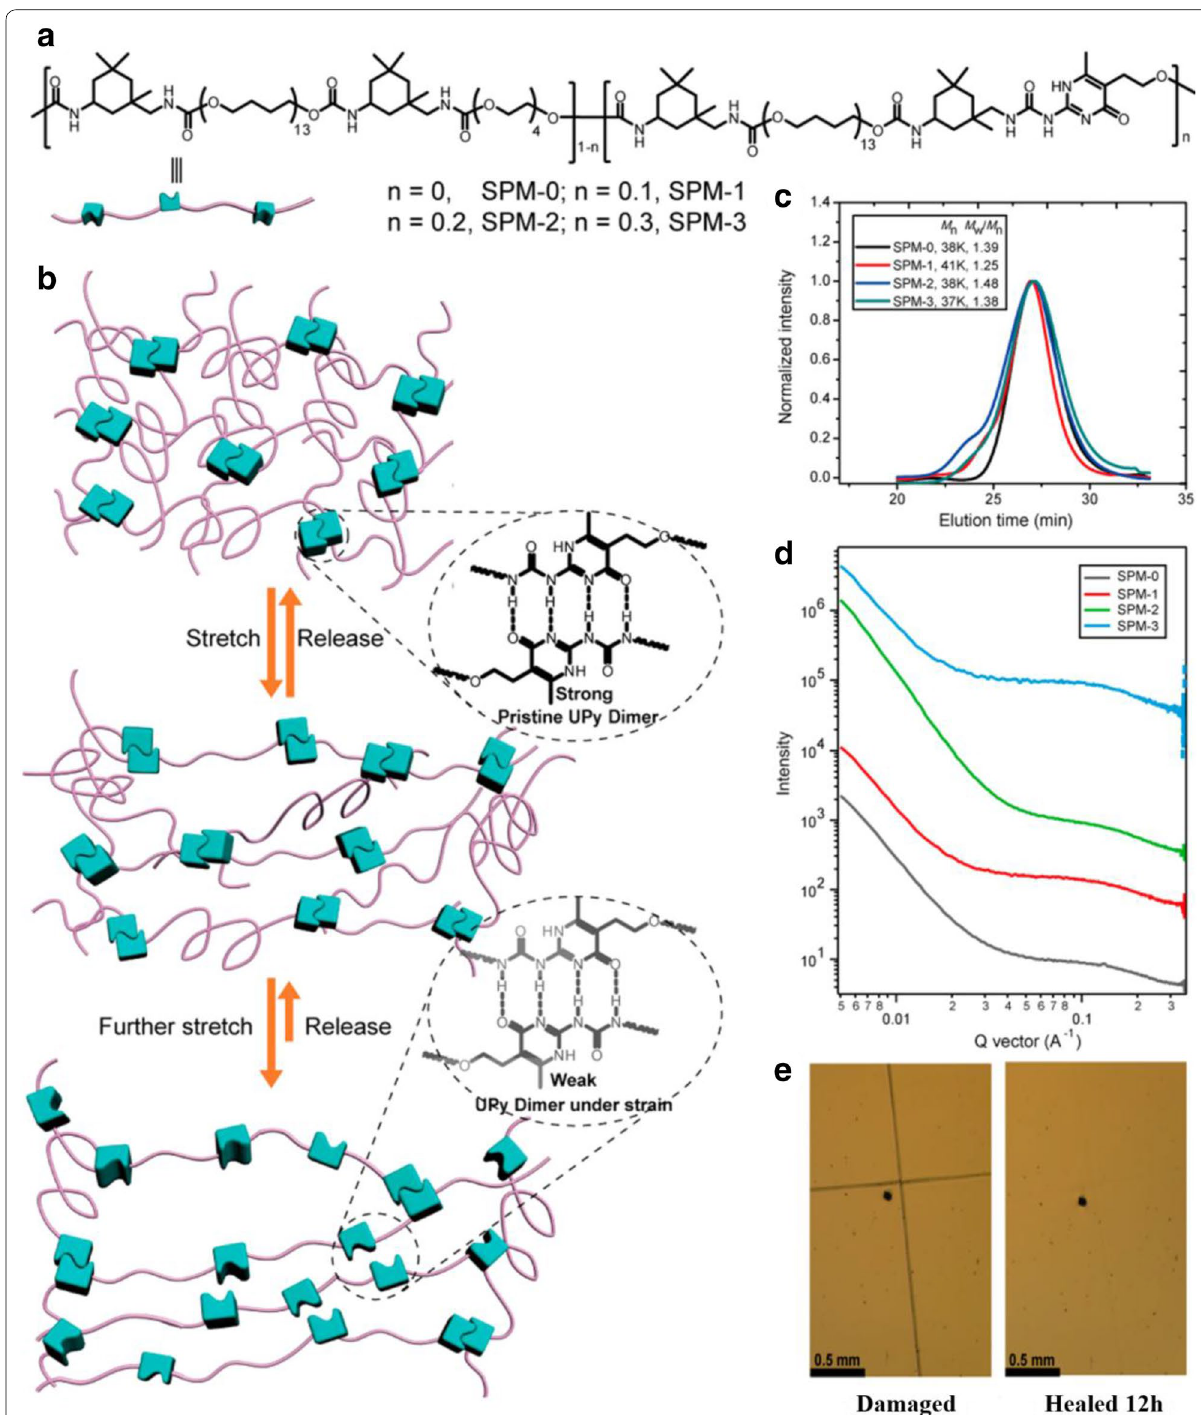
Fig. 5 a Chemical structures of supramolecular polymeric materials (SPMs) with different amounts of stronger UPy quadruple H-bonding and weaker urethane cross-links to tune the properties of SPMs; b schematic illustration of the construction of highly stretchable SPMs; c GPC chromatograms utilizing DMF as the eluent and PMMA as the standard, showing that all polymer are comparable M n and relatively narrow PDI, respectively; d SAXS profile of bulk SPMs that displays broad scattering peaks at 3.7 to 5.2 nm, indicative the presence of microphase separation; e optical images of the damaged and healed SPM film (reproduced with permission from: Ref. [52], ©2018